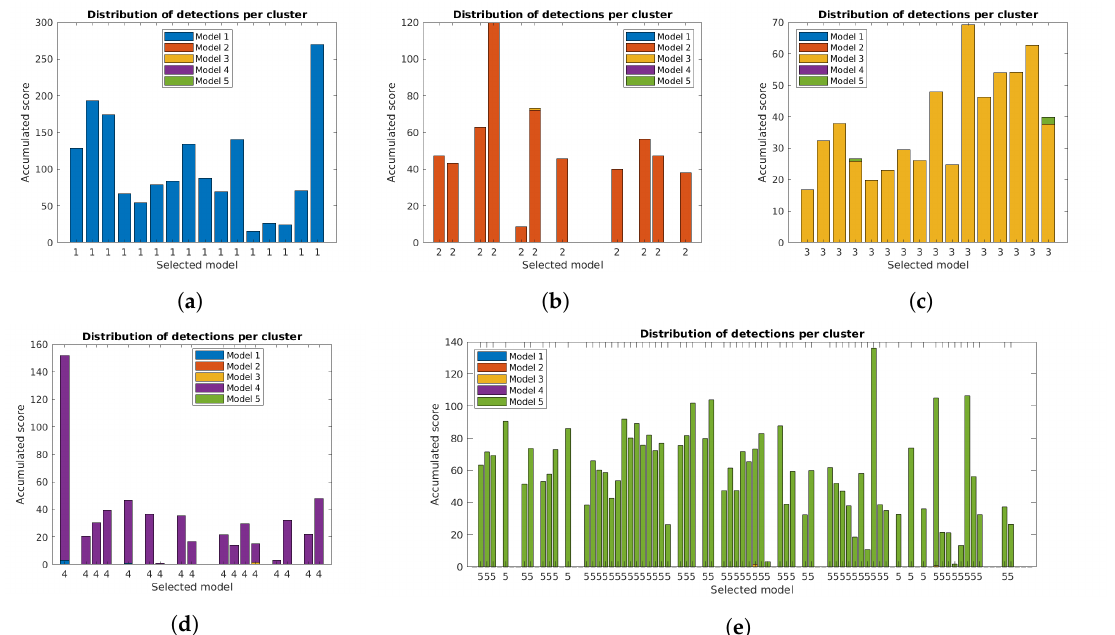
Figure 12. Accumulated scores for each lamp model in each cluster of the five case studies with reprojection error filtering. The model corresponding to the highest value is included below each bar: ( a – e ) Case studies 1 to